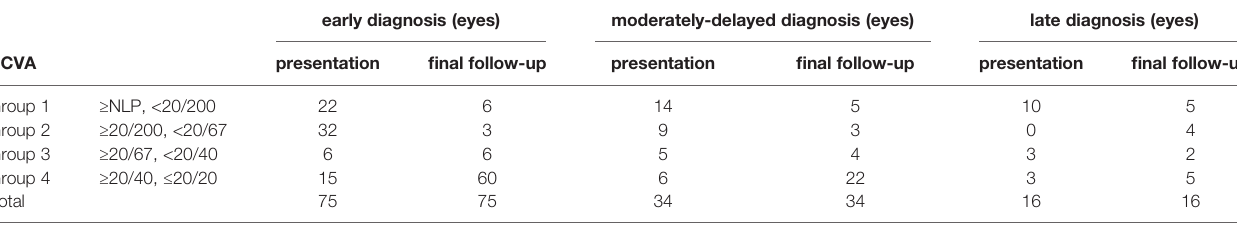
TABLE 3 | Comparison of visual acuity among ocular syphilis eyes with different diagnosis delay. early diagnosis